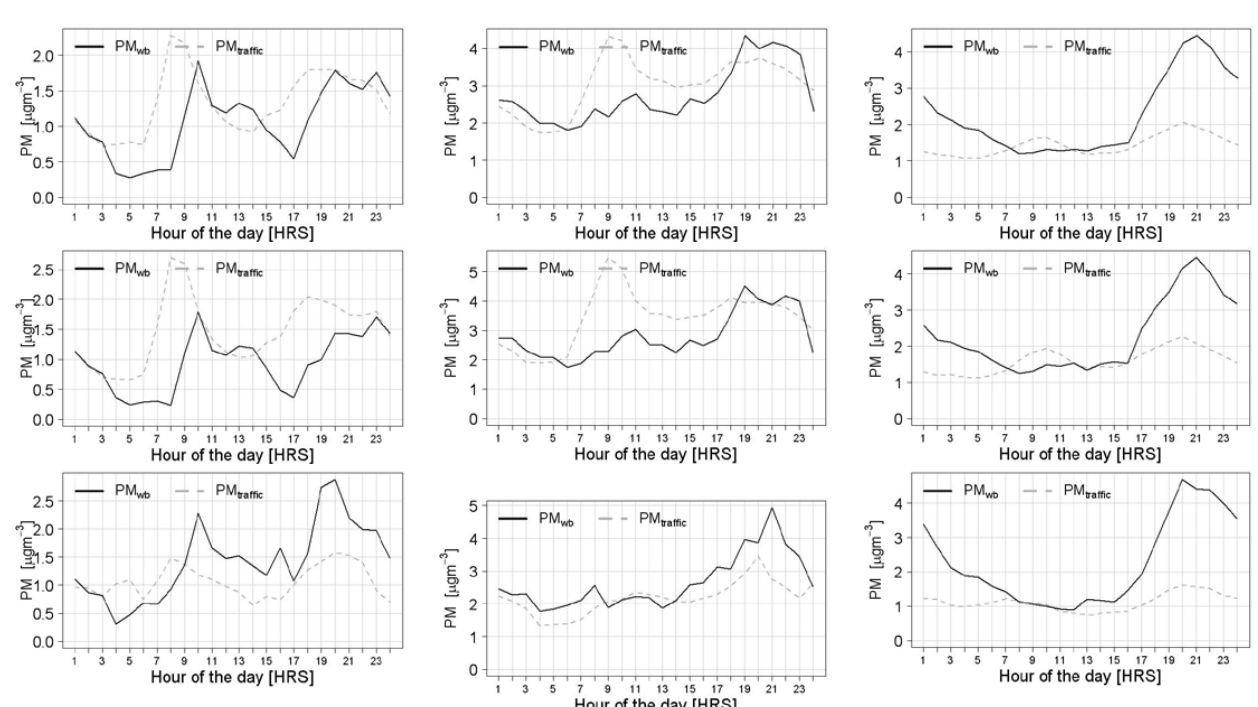
Fig. 3. Diurnal variation of PM wb and PM traf measured at EROS (4 May 2009–31 March 2010) (left panel), North Kensington (16 February– plot: average weekday; bottom panel plots: average week end